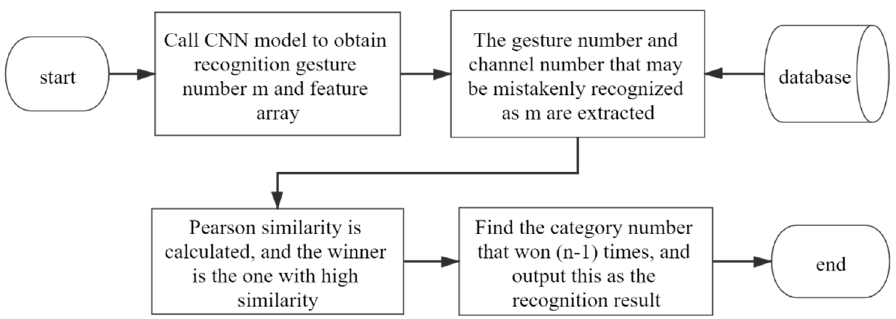
Figure 5. Flow chart of error correction algorithm based on game rules.